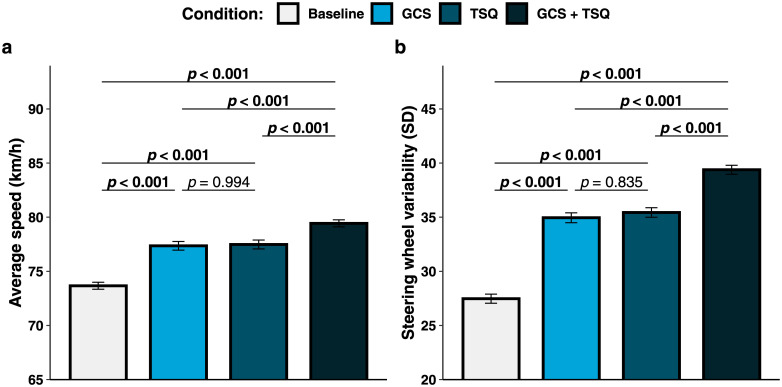
(a) Average speed, and (b) steering wheel variability per condition.Error bars represent standard error of the mean.